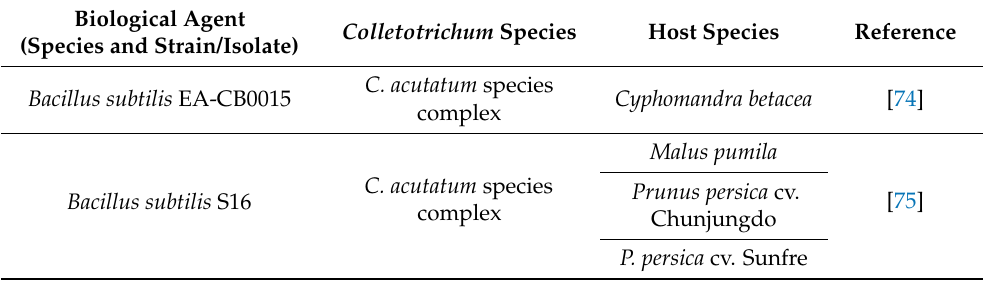
Table 1. Representative biological agents for Colletotrichum spp. management in